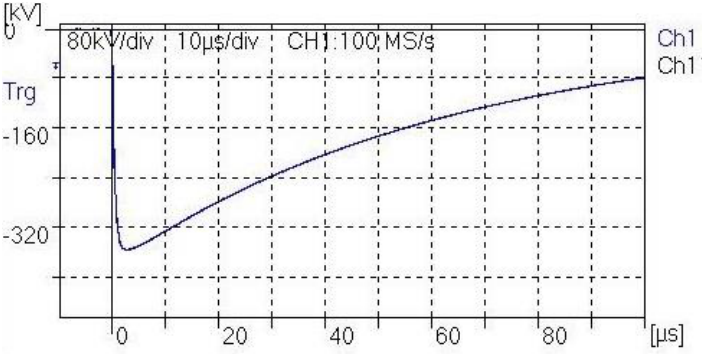
/ 50 µ s impulse at bushing’s terminal with peak of − 356 kV. Figure 16. Application of a 1.2/50 µs impulse at bushing’s terminal with peak of −356 kV. Figure 16. Application of a 1.2